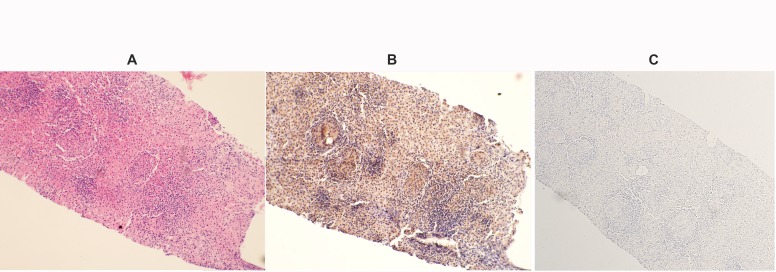
A 28- year-old woman underwent a liver biopsy for evaluation of increased transaminases.At the age of 21 she developed sarcoidosis involving multiple organs, including lungs, eyes, heart and liver. The increased HIF-1α staining in the hepatocytes may reflect the severity of disease in this patient. (A) Hematoxylin-eosin; original magnification X 200 shows multiple granuloma and increased mononuclear cell infiltrates. No significant fibrosis is seen in the H and E staining. (B) Immunohistochemical analysis using a specific antibody against HIF-1α. Staining intensity of HIF-1α was stronger in the mononuclear cells and granulomatous structures, while hepatocytes showed also HIF-1α staining. (C) Negative staining was performed by using isotype control antibody.